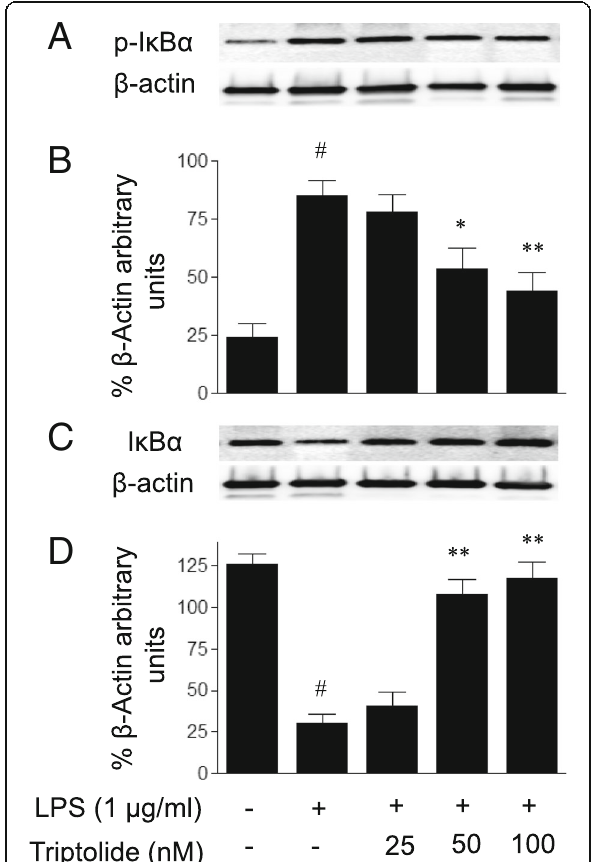
Fig. 5 The effects of triptolide on lipopolysaccharide (LPS)-induced changes in the protein levels of ( a and b ) phosphorylated I κ B α (p- I κ B α ) and ( c and d ) I κ B α in human umbilical vein endothelial cells